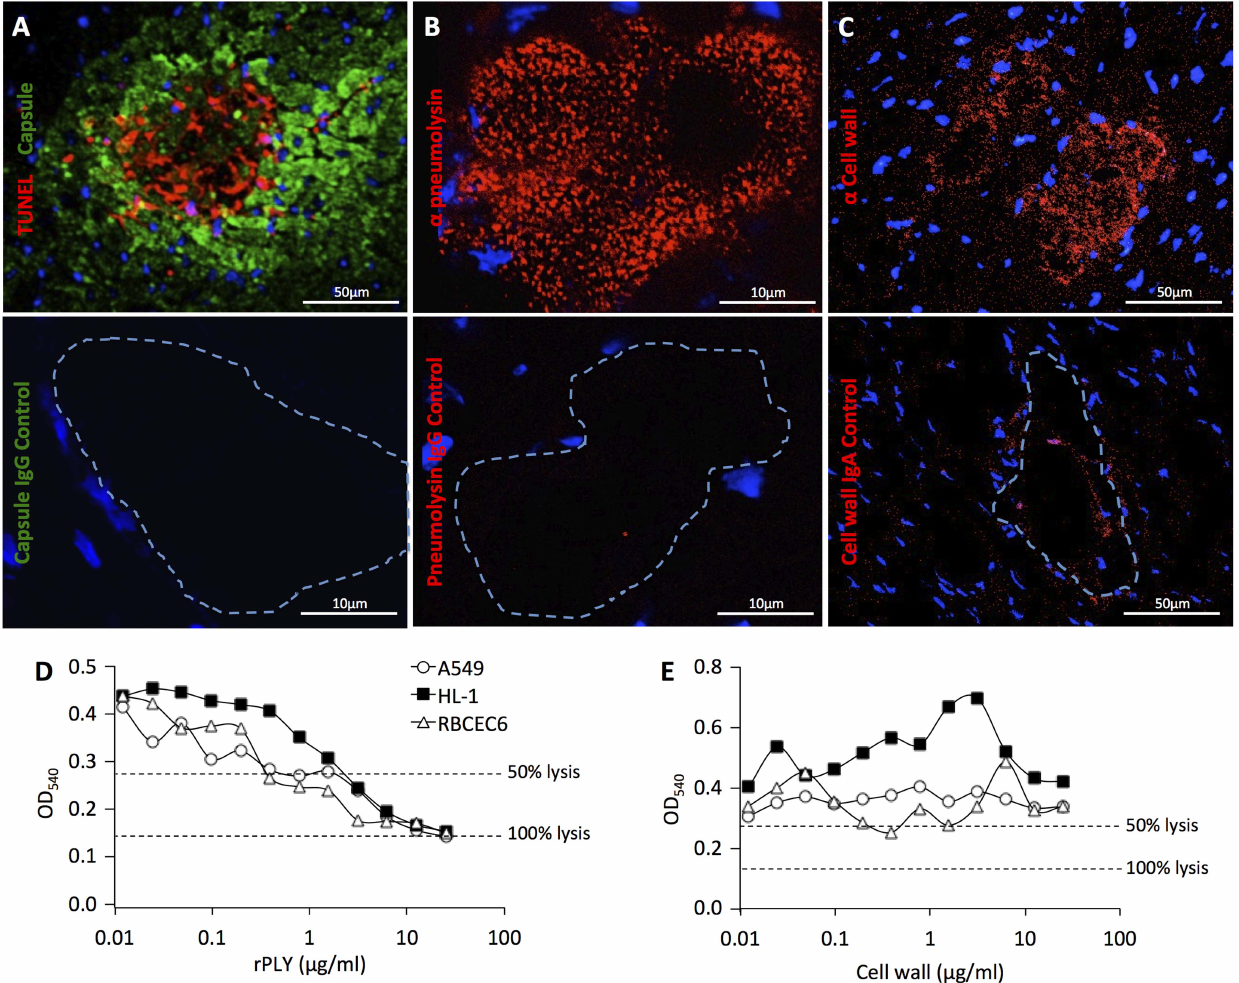
Figure 4. Effect of pneumolysin on cardiomyocyte viability. A) Immunofluorescent TUNEL (red) staining of cardiac microlesions from BALB/c mice 30 h following intraperitoneal infection. Pneumococci were detected using antibodies against serotype 4 capsular polysaccharide (green) and cardiomyocyte nuclei stained with DAPI. B) Detection of pneumolysin (red) in a microlesion using anti-pneumolysin monoclonal antibody. C) Detection of pneumococcal cell wall (red) in microlesions by immunohistochemistry using TEPC-15 an IgA monoclonal antibody against cell wall. For panels A–C) fluorescent microscopy using the corresponding control antibody is shown immediately below. Dashed line demarcates the site of the lesion. Vybrant MTT Cell Proliferation Assay was used to determine cell viability of HL-1, A549, and RBCEC6 cells following their exposure to D) recombinant pneumolysin (rPLY) or E) purified pneumococcal cell wall. Experiments were done 3 times each with 4 replicates. Shown are the results from single, representative